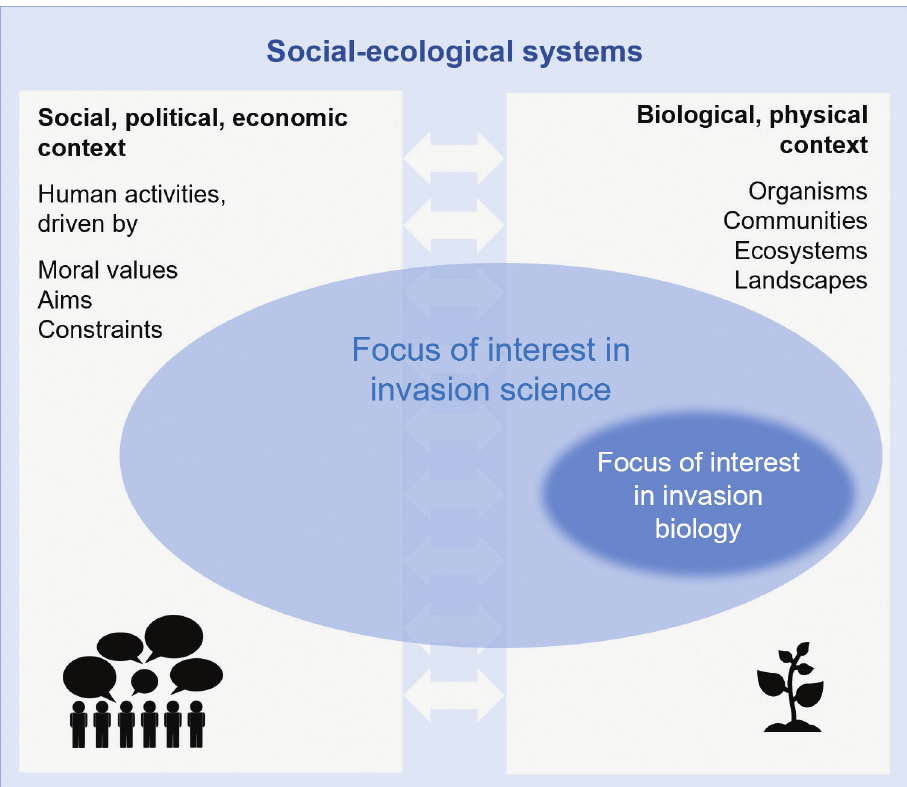
Figure 1. Research on biological invasions is located at the intersection between natural sciences (biologi- cal and physical context) and the social sciences and humanities (social, political and economic context). The concept of ‘social-ecological systems’ (outer light blue box) emphasises that both realms are closely connected, with human activities affecting organisms, communities, ecosystems and landscapes and vice versa. Invasion biology addresses biological questions about patterns and mechanisms of invasions and, thus, has a focal interest in the biological and physical context. The broader field of invasion science con- tains research analysing patterns and mechanisms of invasions from a social-economic point of view, effects of invaders on people’s values and perspectives and many other, non-biological aspects of species